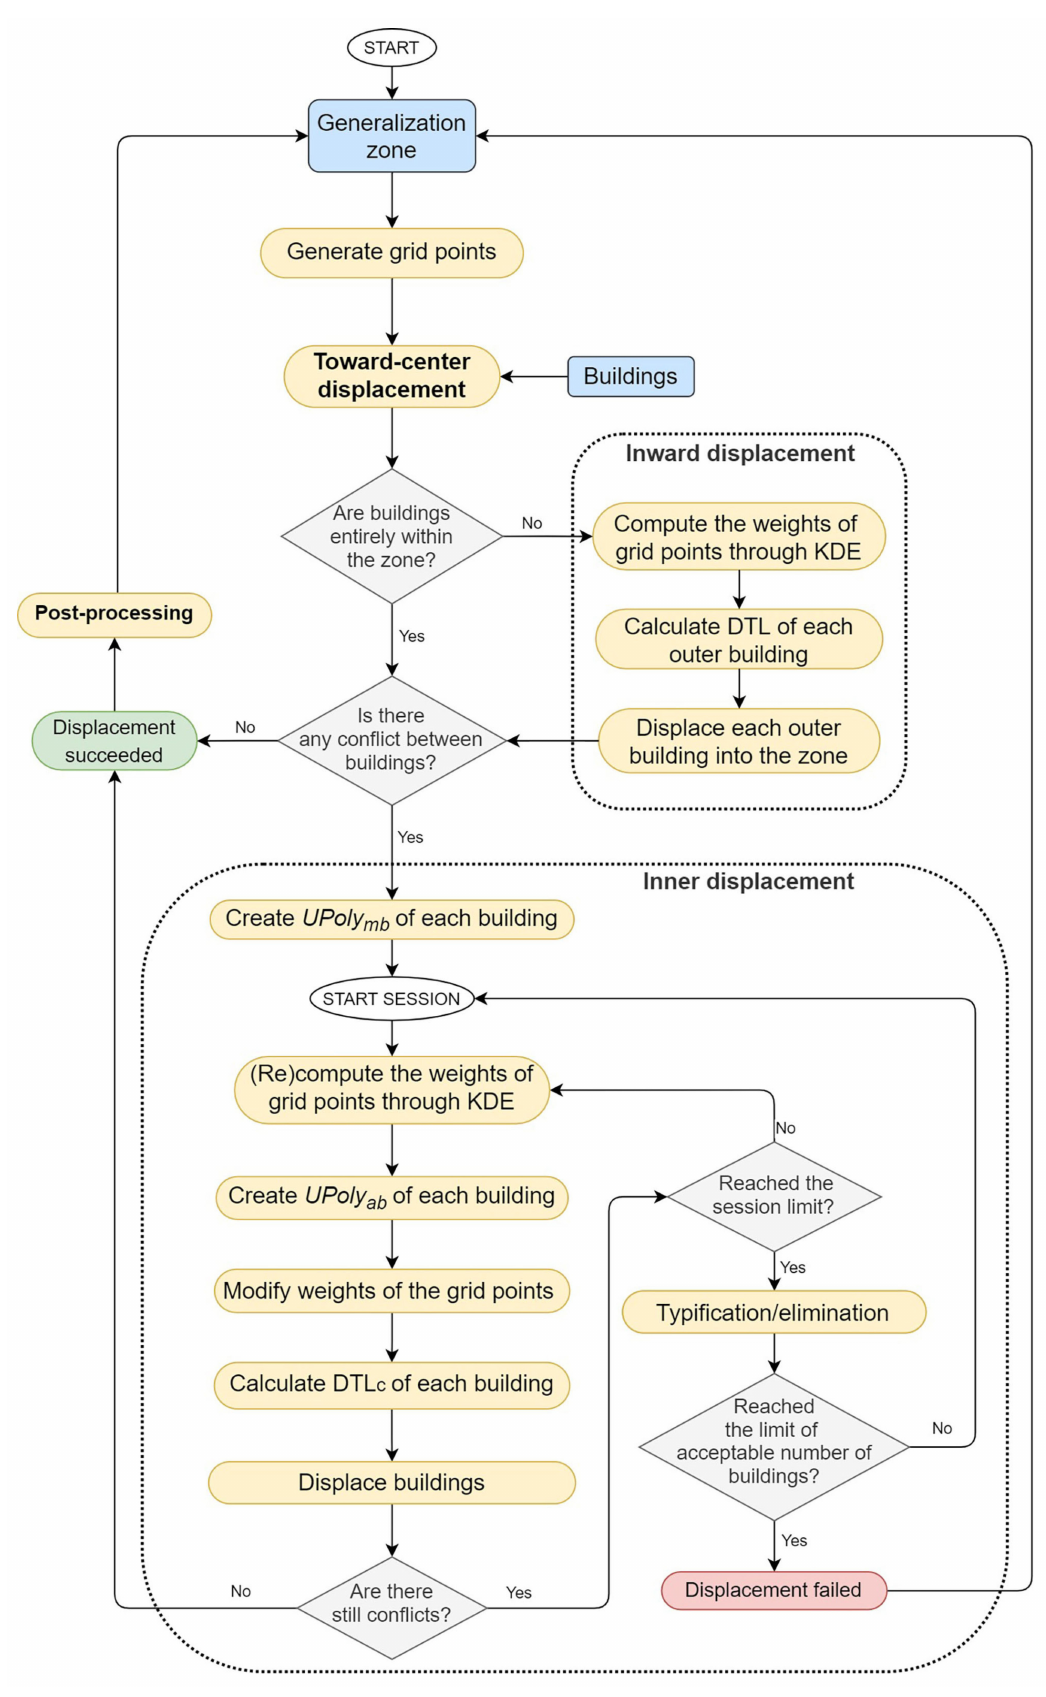
Figure 6. Flow diagram of the displacement